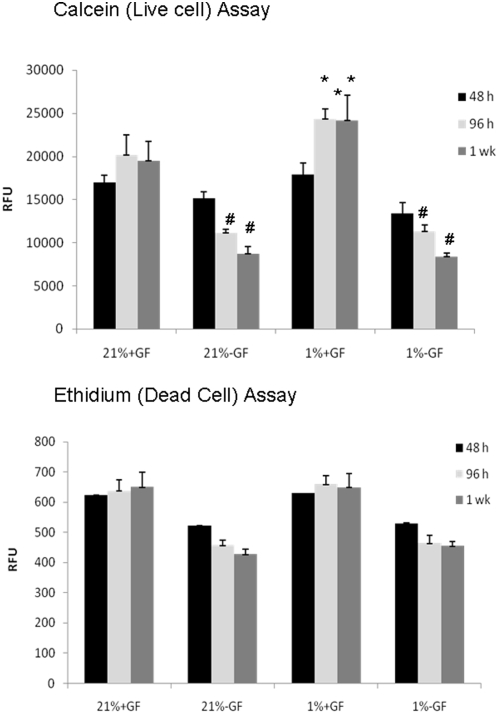
Hypoxia influences on cell viability.Calcein (live) and ethidium (dead) assays of OLs cultured in the presence or absence of GFs in 21%2, 4% or 1% O2 for 48 hrs, 96 hrs, and 7 days. Relative florescence units are shown (RFU). Data are averages of 4 separate studies. (*p<0.01; ANOVA vs. 21% O2+GF; #, P<0.05 ANOVA vs. 21% O2+GF).